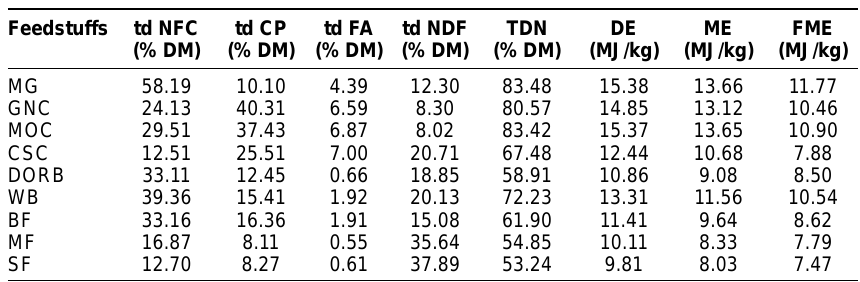
Table-2: TDN, ME and FME content of feedstuffs Feedstuffs td NFC td CP td FA